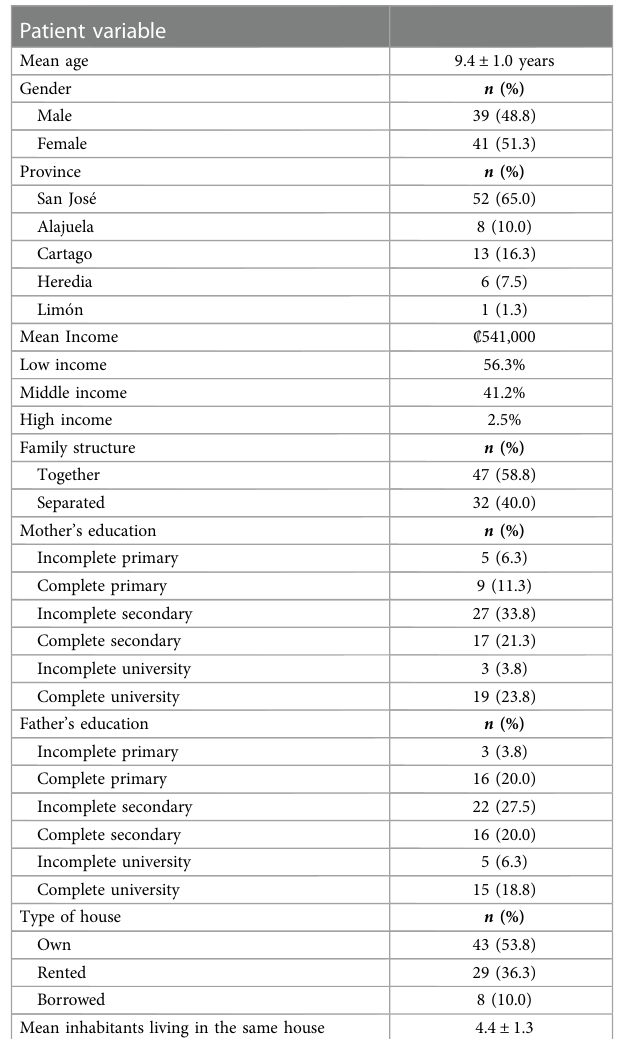
TABLE 1 Sociodemographic characteristics of the